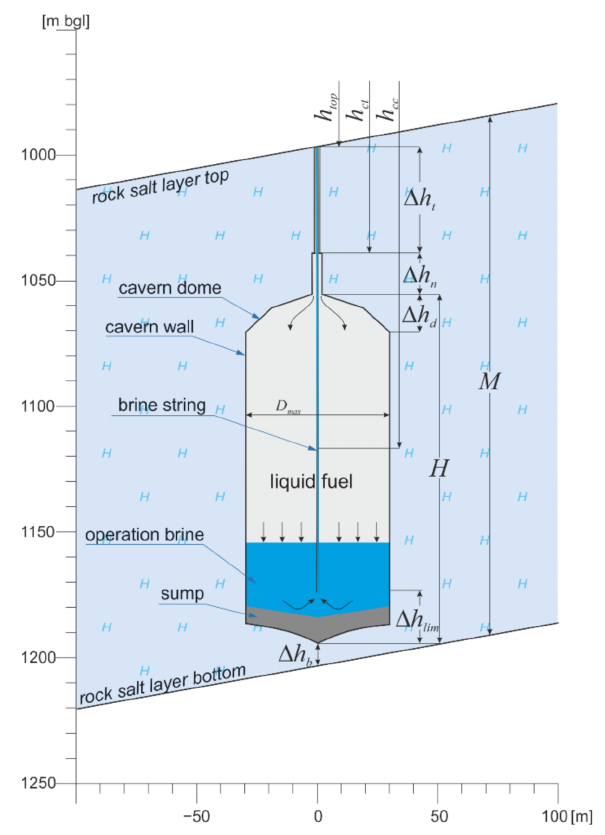
Figure 2. Liquid fuel storage salt cavern—filling of the cavern. The height of the caverns in the bedded rock salt formations depends on the deposit thickness and the total thickness of the rock salt left above and below the storage cavern, ∆ h sum